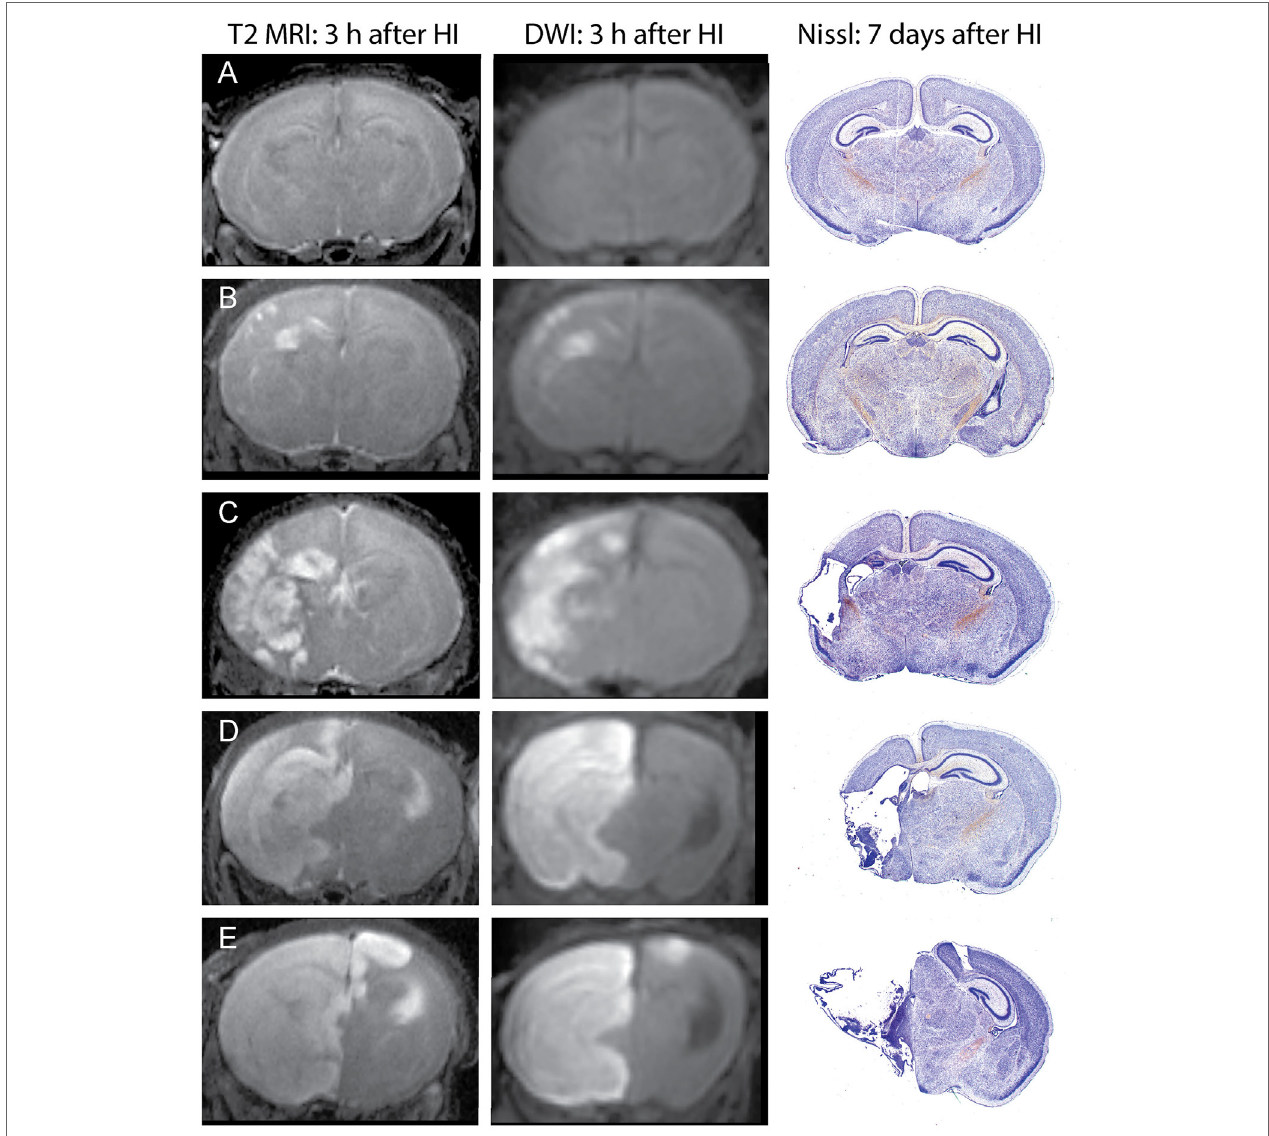
FigUre 2 | Phase 1: T2-weighted magnetic resonance imaging (MRI) and trace DWI obtained 3 h after hypoxic ischemia (HI), with corresponding histological sections demonstrating brain injury, 7 days after HI. Representative images show increased signal consistent with edema in T2-weighted MRIs and a similar pattern of injury in DWI, with corresponding brain injury observed at 7 days in cresyl-violet stained brain sections. Brain injury was scored in the T2-weighted images, with the following total injury scores in the examples shown: (a) no injury (MRI score of 0), (B) mild injury (MRI score 3.5), (c) moderate injury (MRI score 8), (D) severe unilateral injury (MRI score 12), (e) severe bilateral injury (MRI score 15).